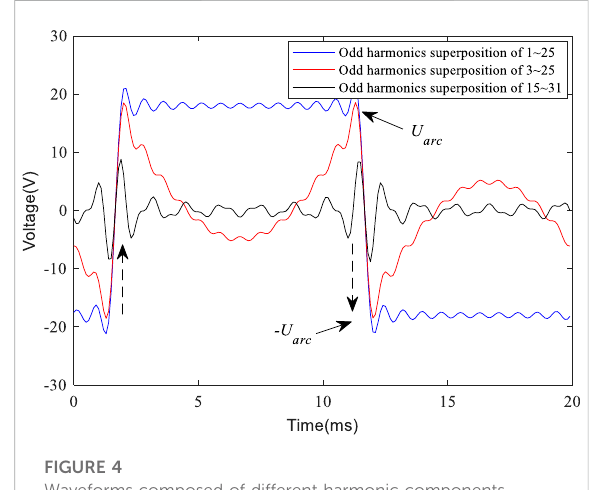
FIGURE 4 Waveforms composed of different harmonic